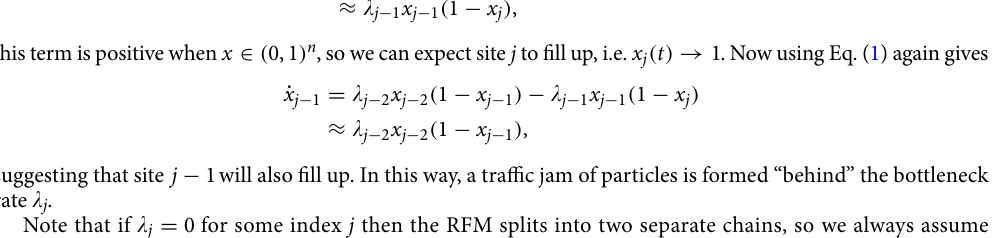
Figure 2. Unidirectional flow along an n site RFM. State variable x i ( t ) density at site i at time t . The parameter (cid:31) i > 0 controls the transition rate from site i to site i controlling the initiation [termination] rate. R ( t ) is the output rate from the chain at time t